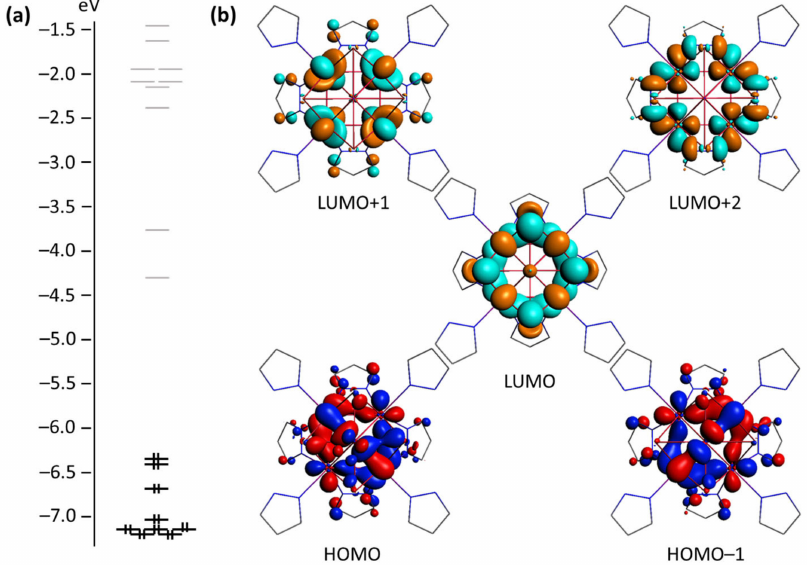
Figure 4. Energy levels diagram ( a ) and frontier molecular orbitals ( b ) of the [{Mo 5 ( µ 3 -Se) 4 ( µ 4 -Se)( µ - pz) 4 }(pzH) 5 ] 2+ cluster (top view representation along the C 4 axis; pzH ligand coordinated to Mo ap atom is hidden for clarity). Isosurface isovalue is 0.035 a.u. Table 2. The bond order values resulting from the calculation for cluster ions [{Mo 5 ( µ 3 -Se) 4 ( µ 4 -Se)( µ